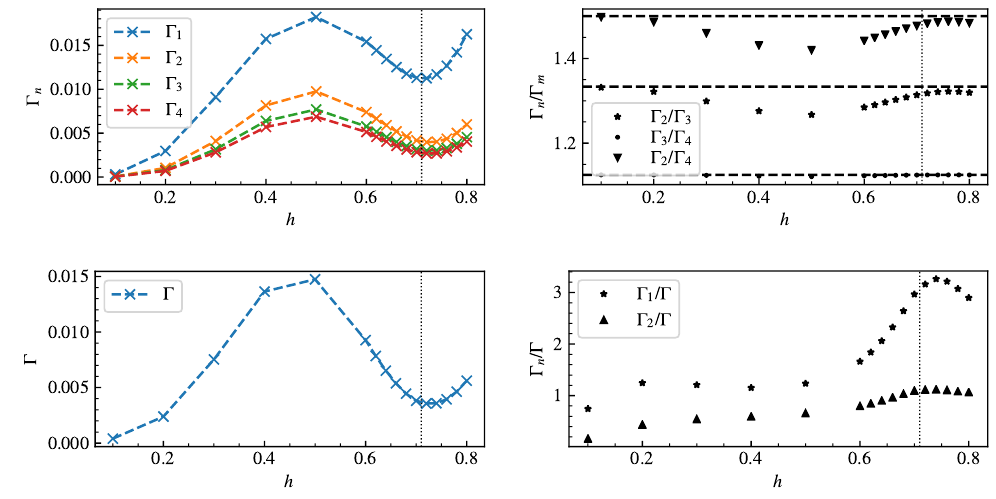
Figure B.6: Left panels: Entropy growth rates Γ (top) and rmagnetisation relaxation n rate Γ (bottom) in units J = 1 for longitudinal quenches in the quantum Potts spin chain starting from g = 2.0 as a function of the longitudinal coupling. Right: Ratios Γ / Γ / Γ (bottom). The dashed lines represent the universal ratios (4.4) (top) and Γ n m n that are restored in the limit h → 0. The vertical line is drawn at the value h where crit the second quasi-particle appears in the post-quench